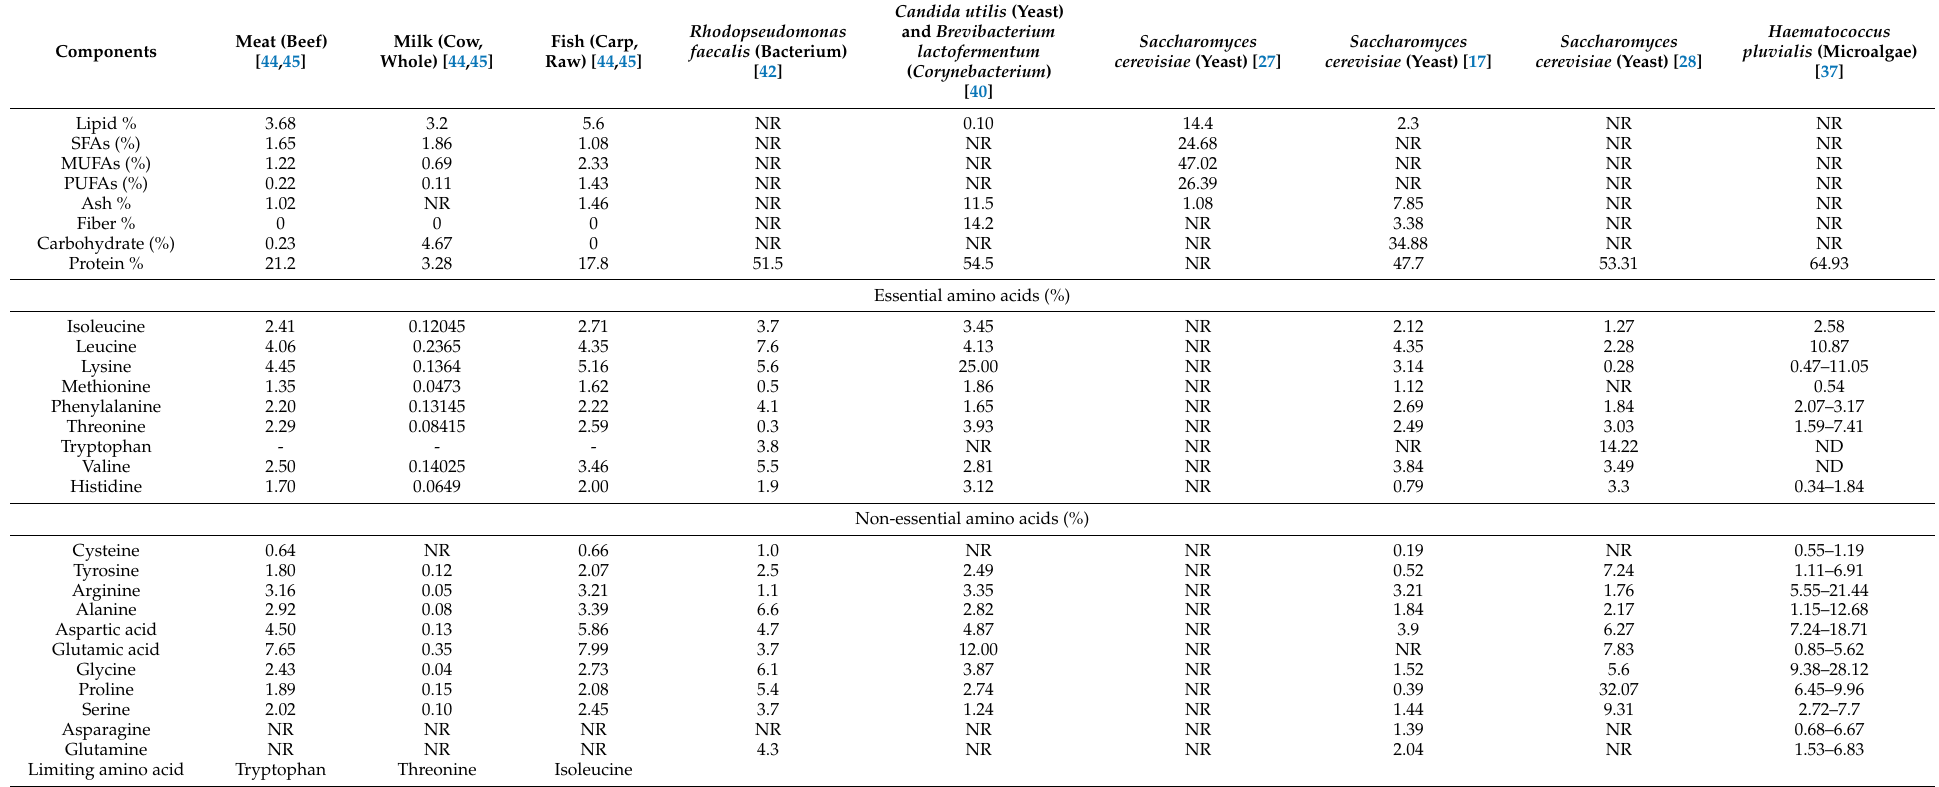
NR: Values not shown were not reported in the respective experiment. ND: not